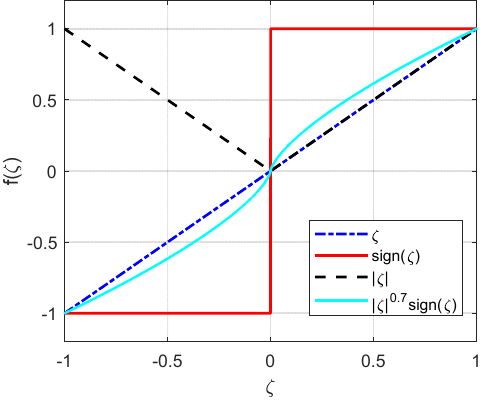
Figure 1. Comparison with sig 0.7 ( ζ ) and the functions ζ , sign ( ζ ) and | ζ |